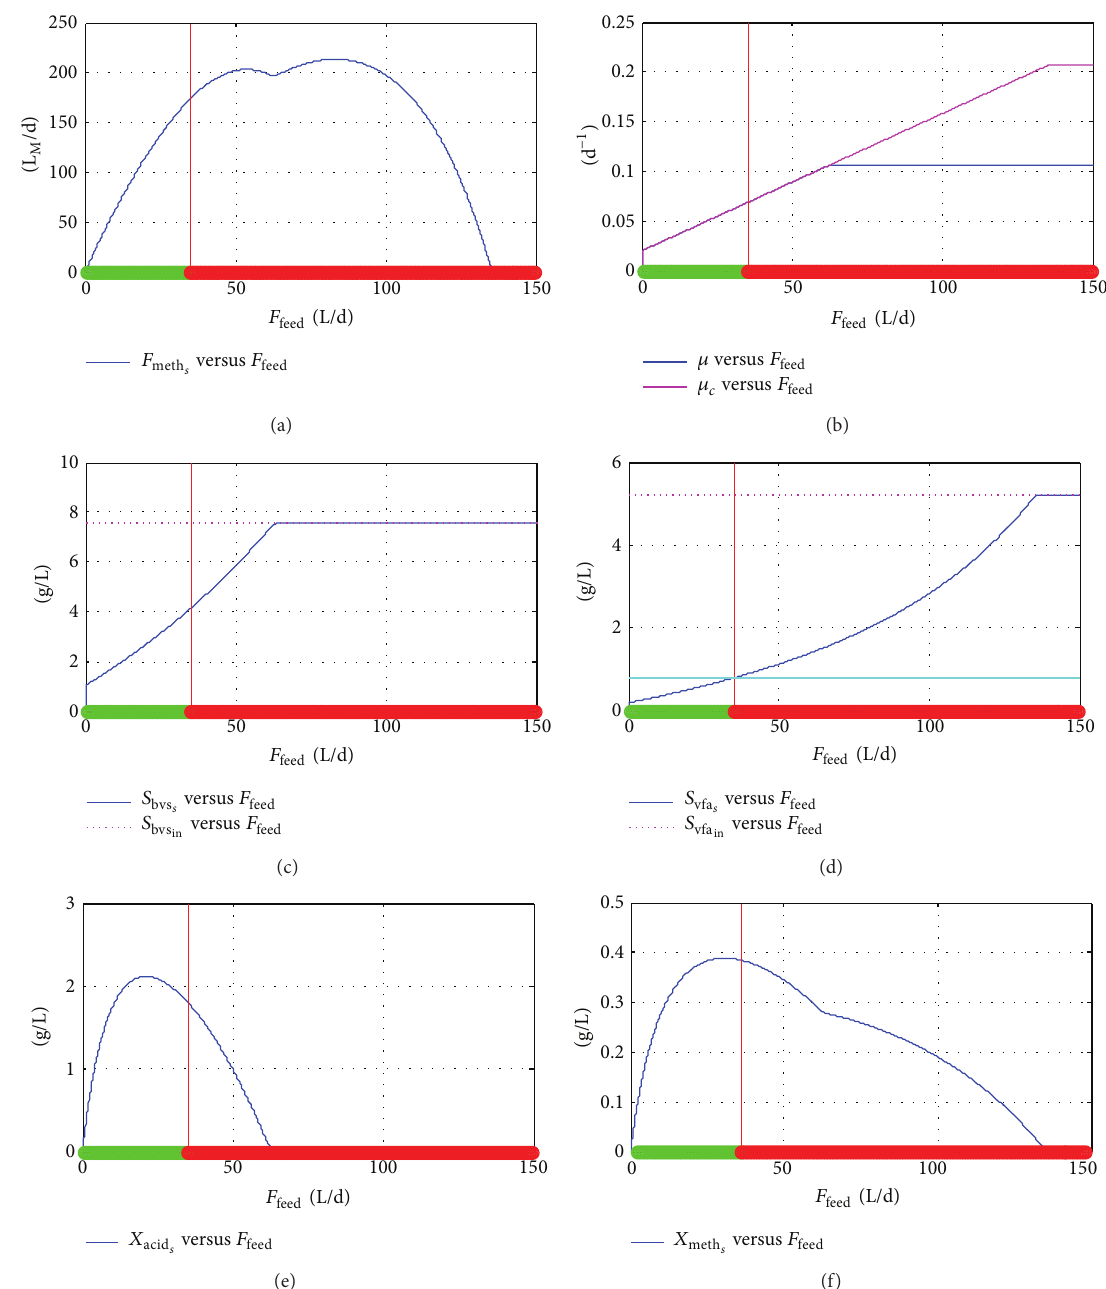
= 35 ∘ C. The green intervals on the (constant) at 𝑇 feed reac